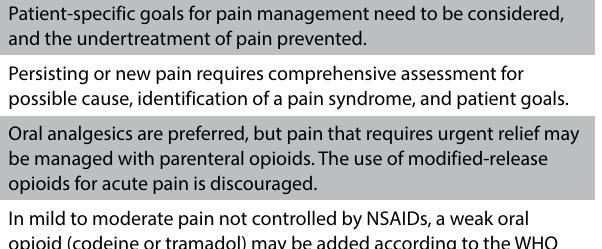
Table 1: Summarized recommendations for opioid use in cancer pain management Patient-specific goals for pain management need to be considered, and the undertreatment of pain prevented. Persisting or new pain requires comprehensive assessment for possible cause, identification of a pain syndrome, and patient goals. Oral analgesics are preferred, but pain that requires urgent relief may be managed with parenteral opioids. The use of modified-release opioids for acute pain is